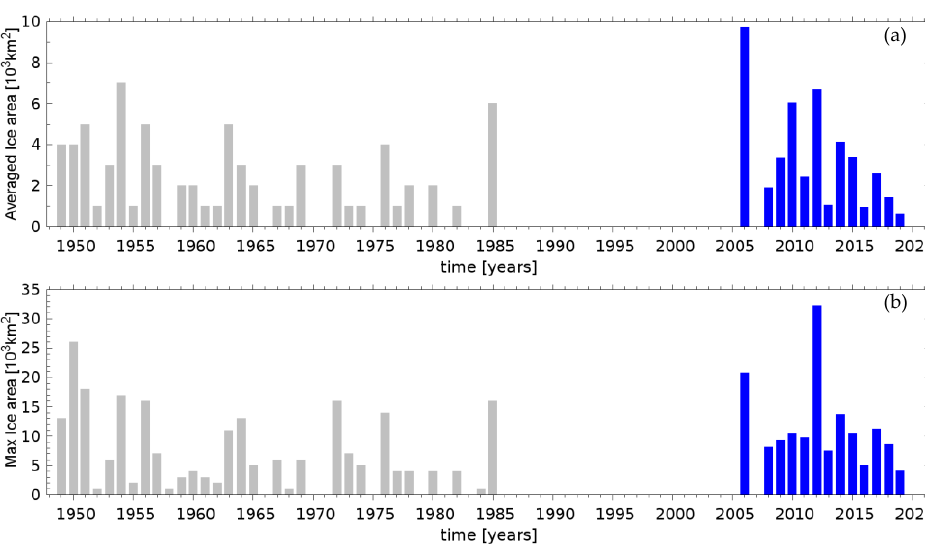
Figure 10. Combined data of sea-ice extent, published in [1] (grey columns) and based on MASIE-NH in the period 2006–2021 (blue columns). The upper panel ( a ) presents the average area for the season December to March, and the lower shows the maximal area covered with ice in the winter season.